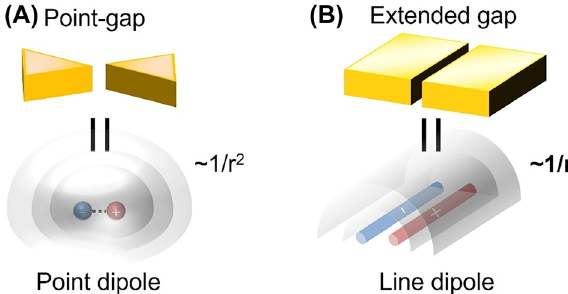
Figure 1: Schematic description of field distribution outside a point-gap and an extended